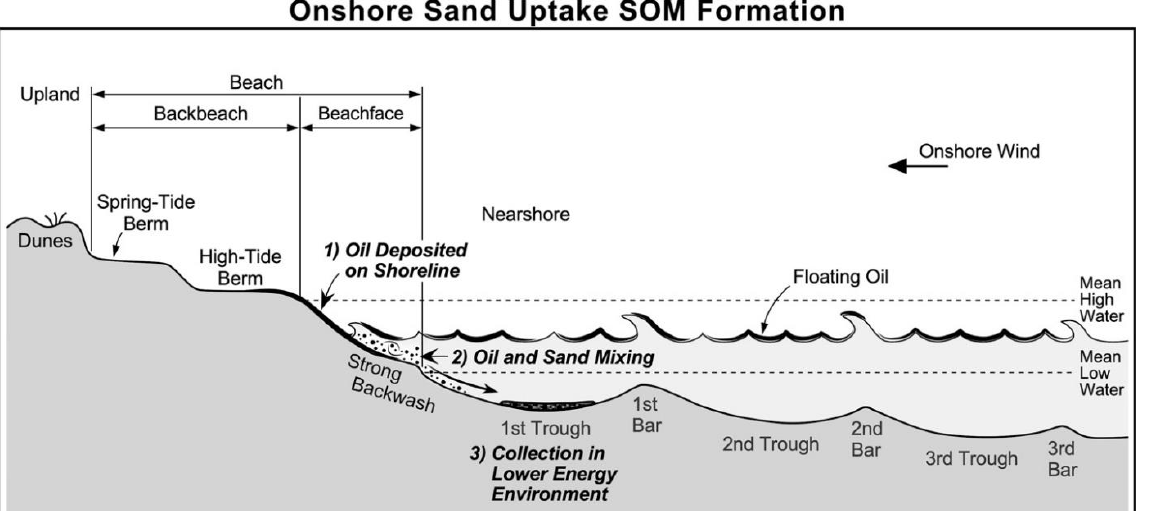
Figure 2. Schematic of the onshore sand uptake process during SOM formation, where stranded oil heavily penetrates into the sand beach and is later eroded during high-wave (plunging) conditions and is deposited by the backwash in the first trough.